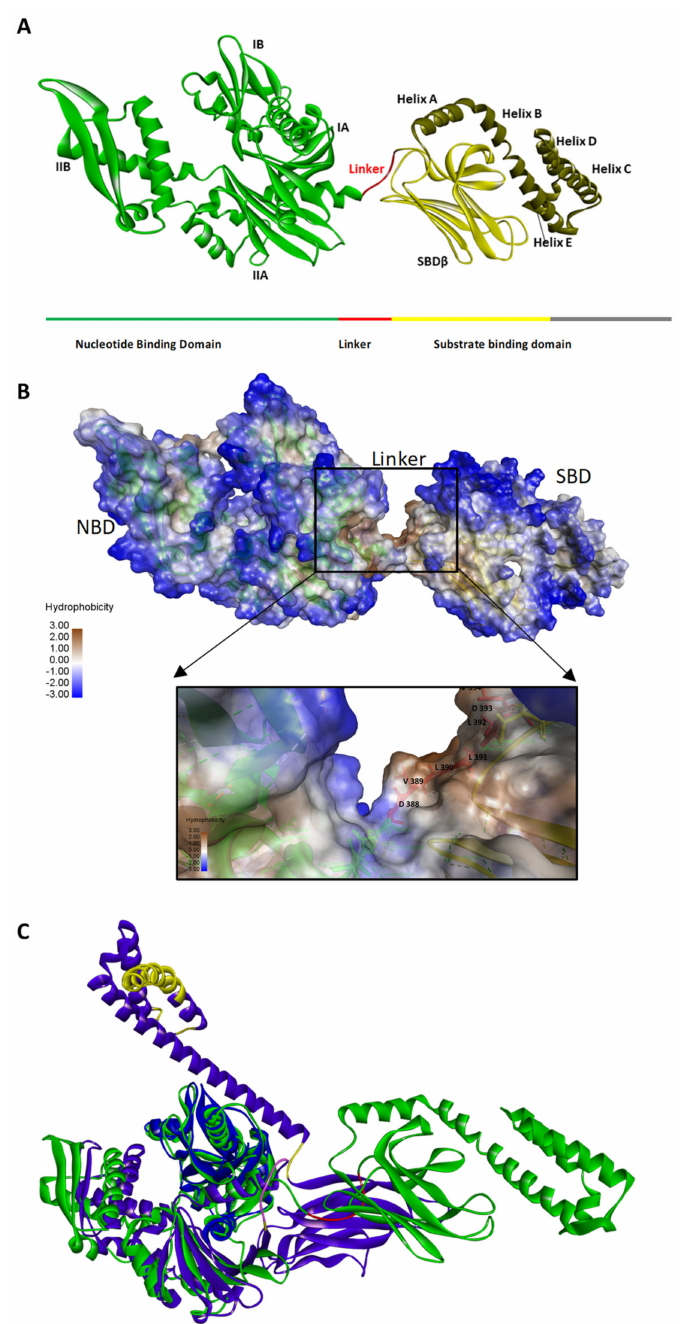
Figure 1. The domain organization of heat shock 70 (Hsp70). Three-dimensional model of E. coli Hsp70 (DnaK) showing domain organization ( A ). The N-terminal nucleotide binding domain (NBD) is made up of lobes IA, IIA, IB and IIB (Green). The substrate binding domain (SBD) is made of the SBD β (yellow) which forms the substrate binding cleft and the SBD α which is characterized by helices A, B, C, D and E (brown). The linker connects the NBD and SBD of Hsp70s (red). The linker of canonical Hsp70s is typically hydrophobic in nature, as confirmed by after hydrophobicity analysis of residues using discovery studio visualizer (https: // www.3dsbiovia.com). ( B ) A three-dimensional model of a canonical Hsp70 (green) with the linker highlighted (red). The three-dimensional model of a canonical Hsp70 (P0A648; green) was superimposed against that of Hsp110 (P32589; blue) whose linker (purple) and acidic insertions (yellow) are highlighted ( C ). The modelling was conducted using template C3c7n.1A.pdb [14] on Chimera